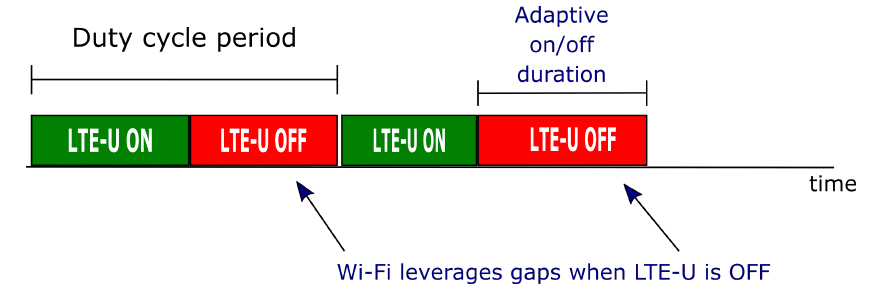
Figure 2. LTE duty cycle